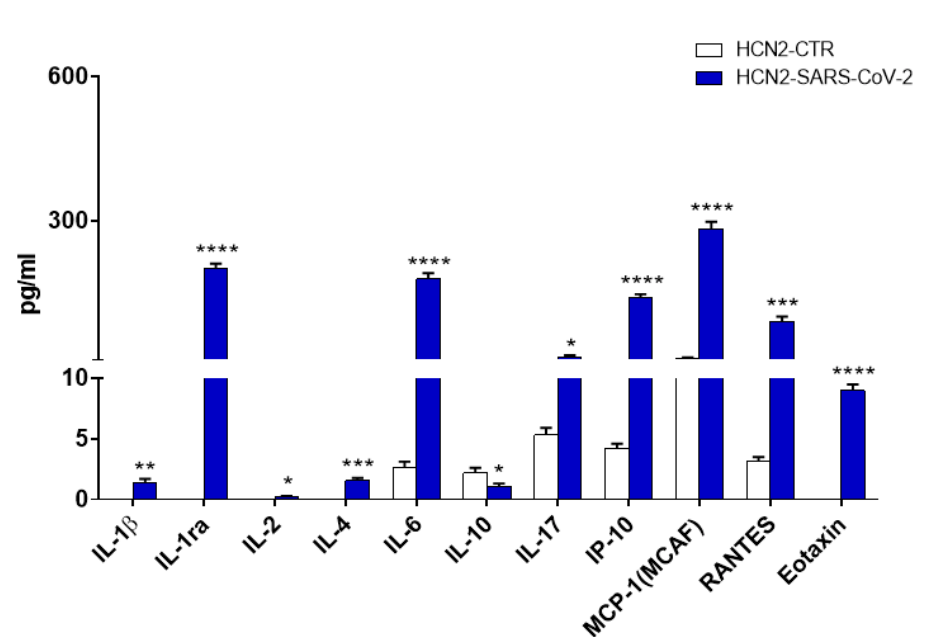
Figure 5. Concentration of cytokines/chemokines in cell culture supernatants 6 days post infection. * p < 0.05; ** p < 0.01; *** p < 0.001; **** p < 0.0001 compared to HCN2-CTR. IP-10 ( CXCL10 ), MCP-1 ( CCL2 ), and RANTES ( CCL5 ) increase confirmed the results